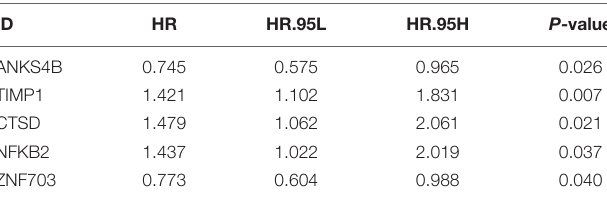
TABLE 1 | Results of the univariate Cox regression analysis between gene expression and